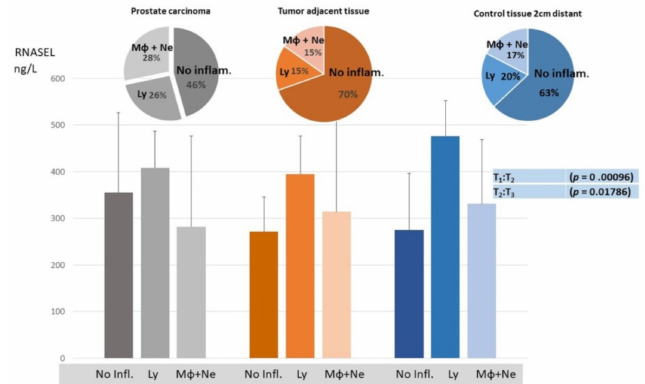
Figure 7. RNASEL in PC, tumor-adjacent and corresponding healthy tissues in relation to the presence and the type of inflammation.